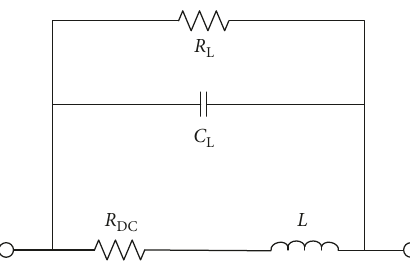
Figure 8: Equivalent model of the inductor.